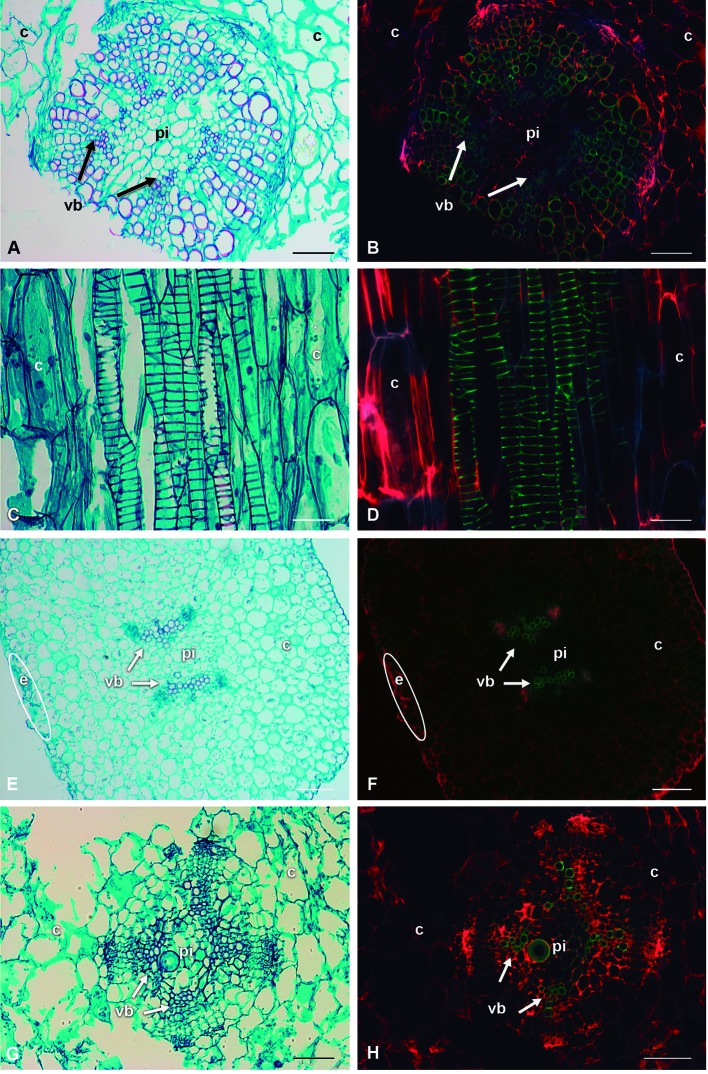
Comparison of bright-field illumination and fluorescence microscopy with triple-band excitation of seedling stems. (A, C, E, G) Bright-field illumination. (B, D, F, H) Fluorescence emission. (A, B)
Lophocereus marginatus, transverse sections. (C, D)
Lophocereus marginatus, longitudinal sections. (E, F)
Leuenbergeria lychnidiflora, transverse sections. (G, H)
Opuntia streptacantha, transverse sections. Scale: (A, B, E–H; 100 µm. C, D: 50 µm. c, cortex; e, epidermis; pi, pith; vb, vascular bundle).